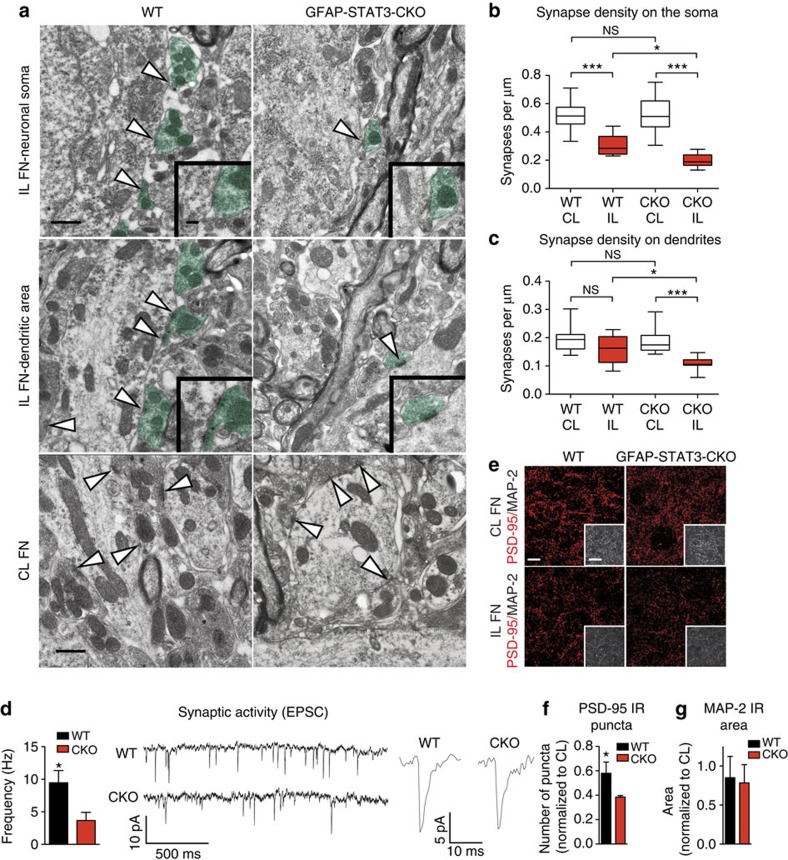
STAT3-mediated AC response corresponds with greater synaptic density and input onto neurons.(a) Electron micrographs of axosomatic and axodendritic synapses within a 50 μm radius from the soma in the IL and CL FN 14 days post axotomy. WT mice, in contrast to CKO mice, have more presynaptic terminals (green) opposing the postsynaptic density (arrowheads). Insets demonstrate postsynaptic densities. (b) Number of synaptic contacts (μm−1) along the surface of the soma (WT n=12 cells, CKO n=17 cells) and (c) within the dendritic area (WT n=13 dendrites, CKO n=12 dendrites, * P<0.05, ***P<0.001, one-way analysis of variance P<0.0001). (d) Frequency of excitatory postsynaptic currents from whole-cell recordings in the IL FN 12–14 days post axotomy (WT n=5, CKO n=6, *P=0.036, t-test), and representative trace recordings with single EPSCs. (e) Confocal images of immunostained acute brainstem slices of axotomized postnatal (P21–23) mice processed after electrophysiological studies. Examples demonstrating PSD-95 IR synapses (red) and MAP-2 IR dendrites (insets, white) in the CL and IL FN at 12–14 days post axotomy. (f) Means of number of PSD-95 IR puncta (n=3 mice, *P=0.041, t-test) and (g) MAP-2 IR areas (n=3 mice, NSP=0.176, t-test) normalized by CL values in the same section. Scale bar, 0.5 μm for a; 0.1 μm for insets; 10 μm for e and 25 μm for insets. Data represent mean±s.e.m.